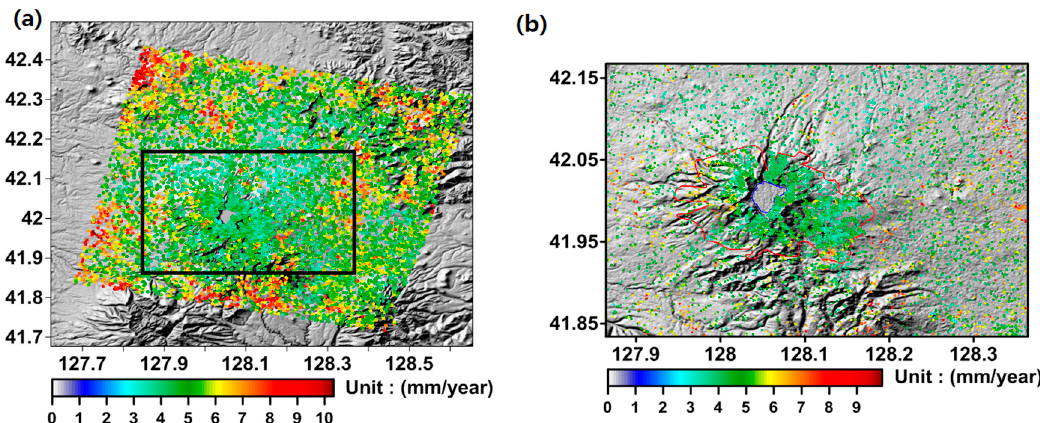
Figure 8. The map of mean precision dispersion ( a ) of mean velocity corresponding to the extent shown on Figure 7. and zoomed-in on ( b ). The area covered with a low number dots represents the area with high estimated precision. The area outlined by the red line in ( b ) is the timberline area.